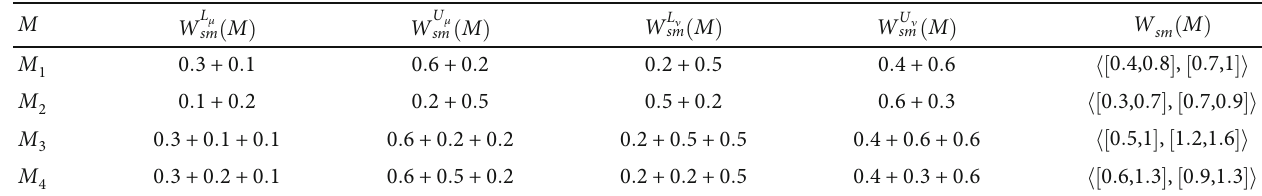
Table 6: Calculating the weight of perfect strong matchings M